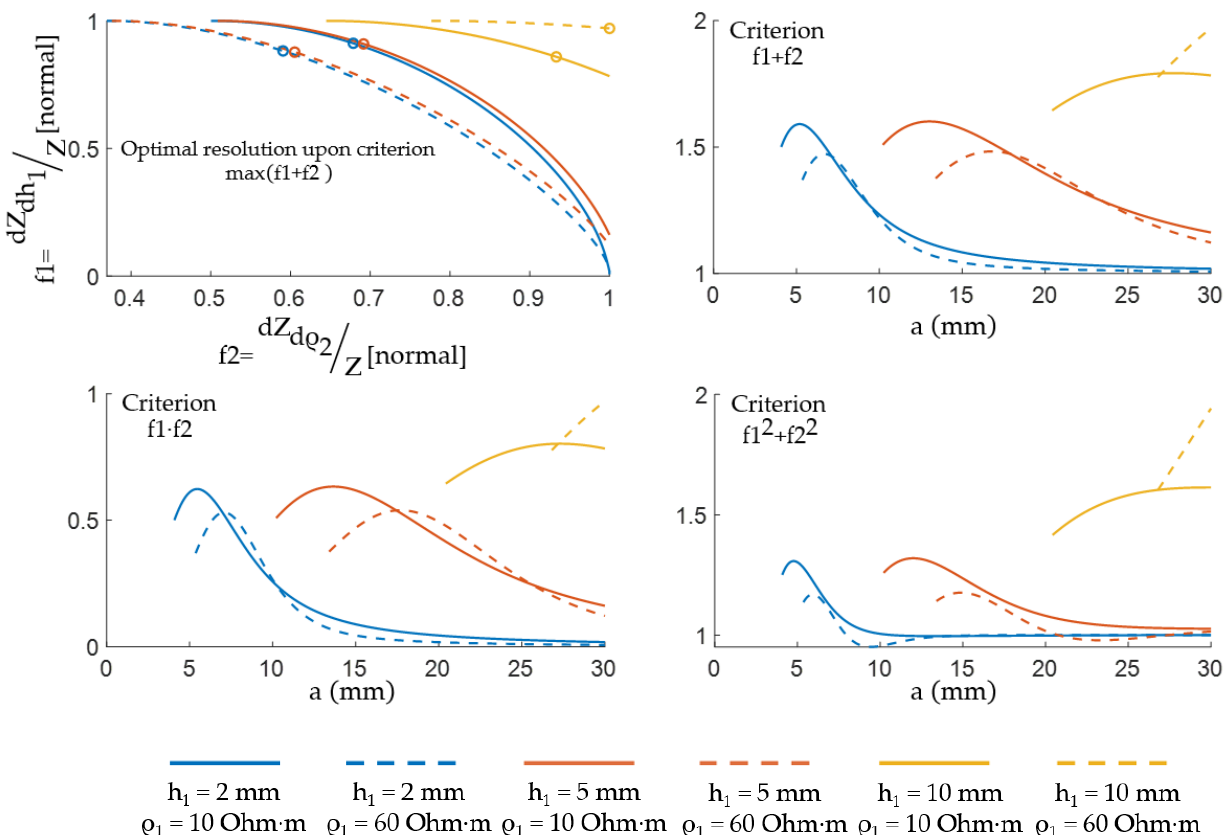
Figure 16. Multiobjective optimization problem solving for dZ dh The circles highlight the optimal solutions based on the objective functions’ sums